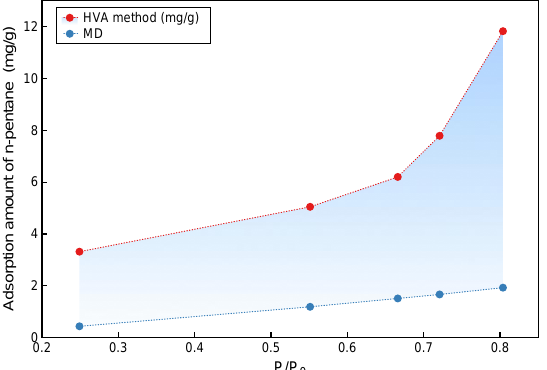
Figure 8. Variation of n-pentane adsorption with relative pressure obtained from HVA at 313 K.